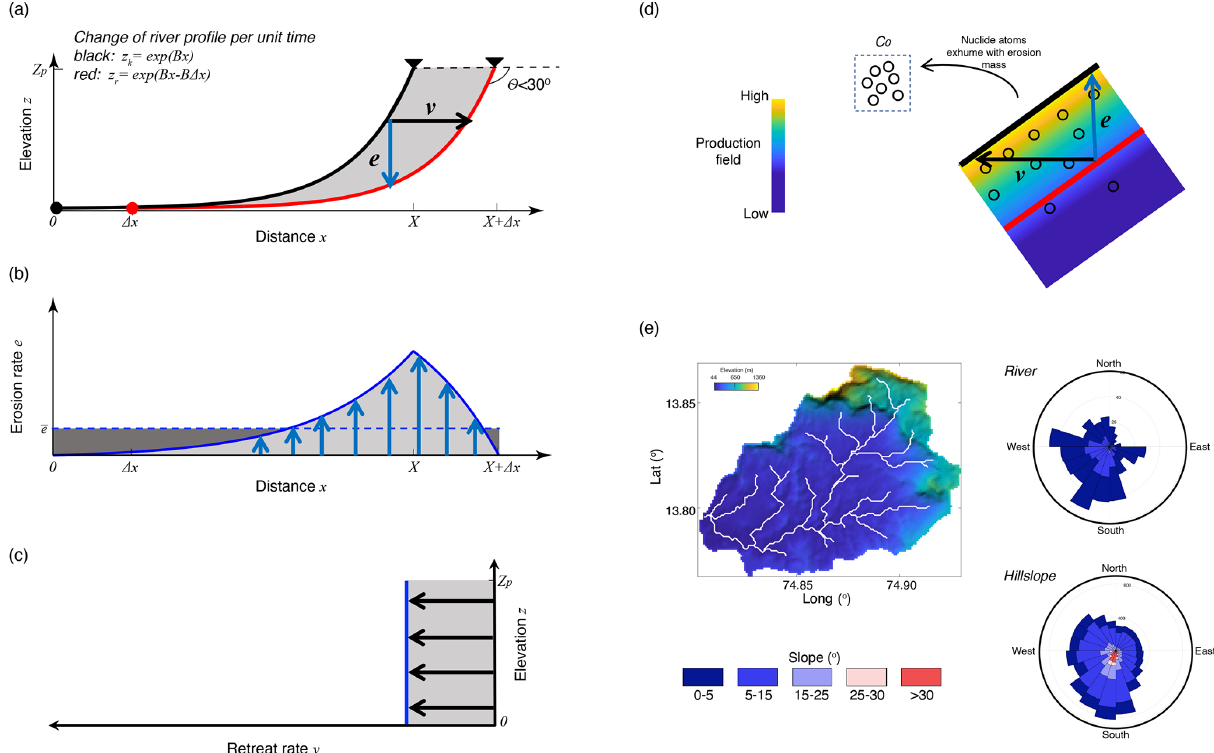
Figure 7. Relationship between mass flux through a surface and the velocity for a retreating escarpment. (a) Land surface, assumed to be exponential in form, retreating into a pre-existing highland at constant velocity, v . The surface lowering at any point is given as e . (b) Surface lowering rate as a function of distance. (c) Horizontal velocity as a function of elevation. Velocity is constant in both elevation and distance. Areas under the curves (light and dark gray) in panels (a) , (b) and (c) represent the mass flux and are equal in all cases. (d) CN production zone below a dipping surface. Rock motion in either vertical or horizontal direction brings particles to the surface with an integrated production. For a constant flux, v and e scale so that the time of passage through the production zone is independent of direction, so surface concentration is independent of direction. (e) Elevation of a typical catchment in the Western Ghats with rose diagrams showing frequency and magnitude of slope with direction for channels (upper) and hillslopes